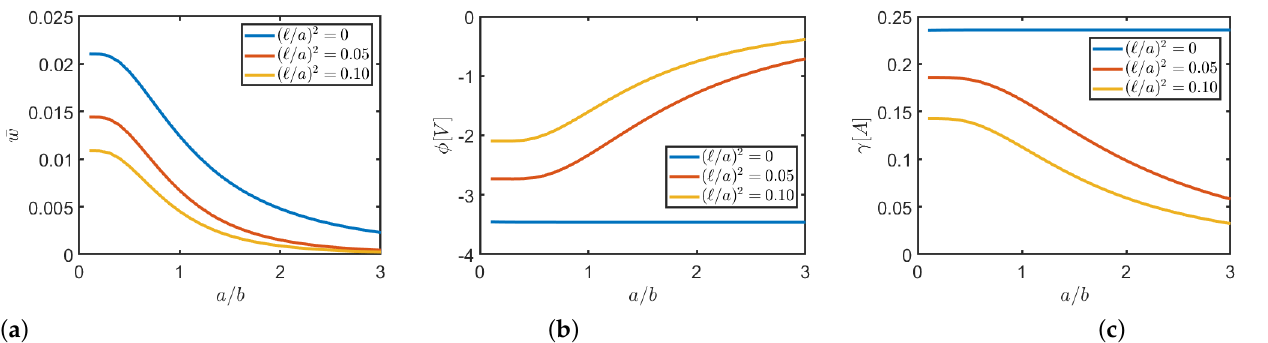
Figure 9. Displacement ¯ w ( a ) electric φ ( b ) and magnetic γ ( c ) potential, at the central point ( a /2, b /2 ) by varying a / b ratio and for different nonlocal parameter ( (cid:96) / a ) 2 with n p = 1 (UDL; q = 0 N/m 2 , T 0 = 0 K, T 1 = 1 K, ρ E = 0 C/m 2 , ρ H = 0 Wb/m 2